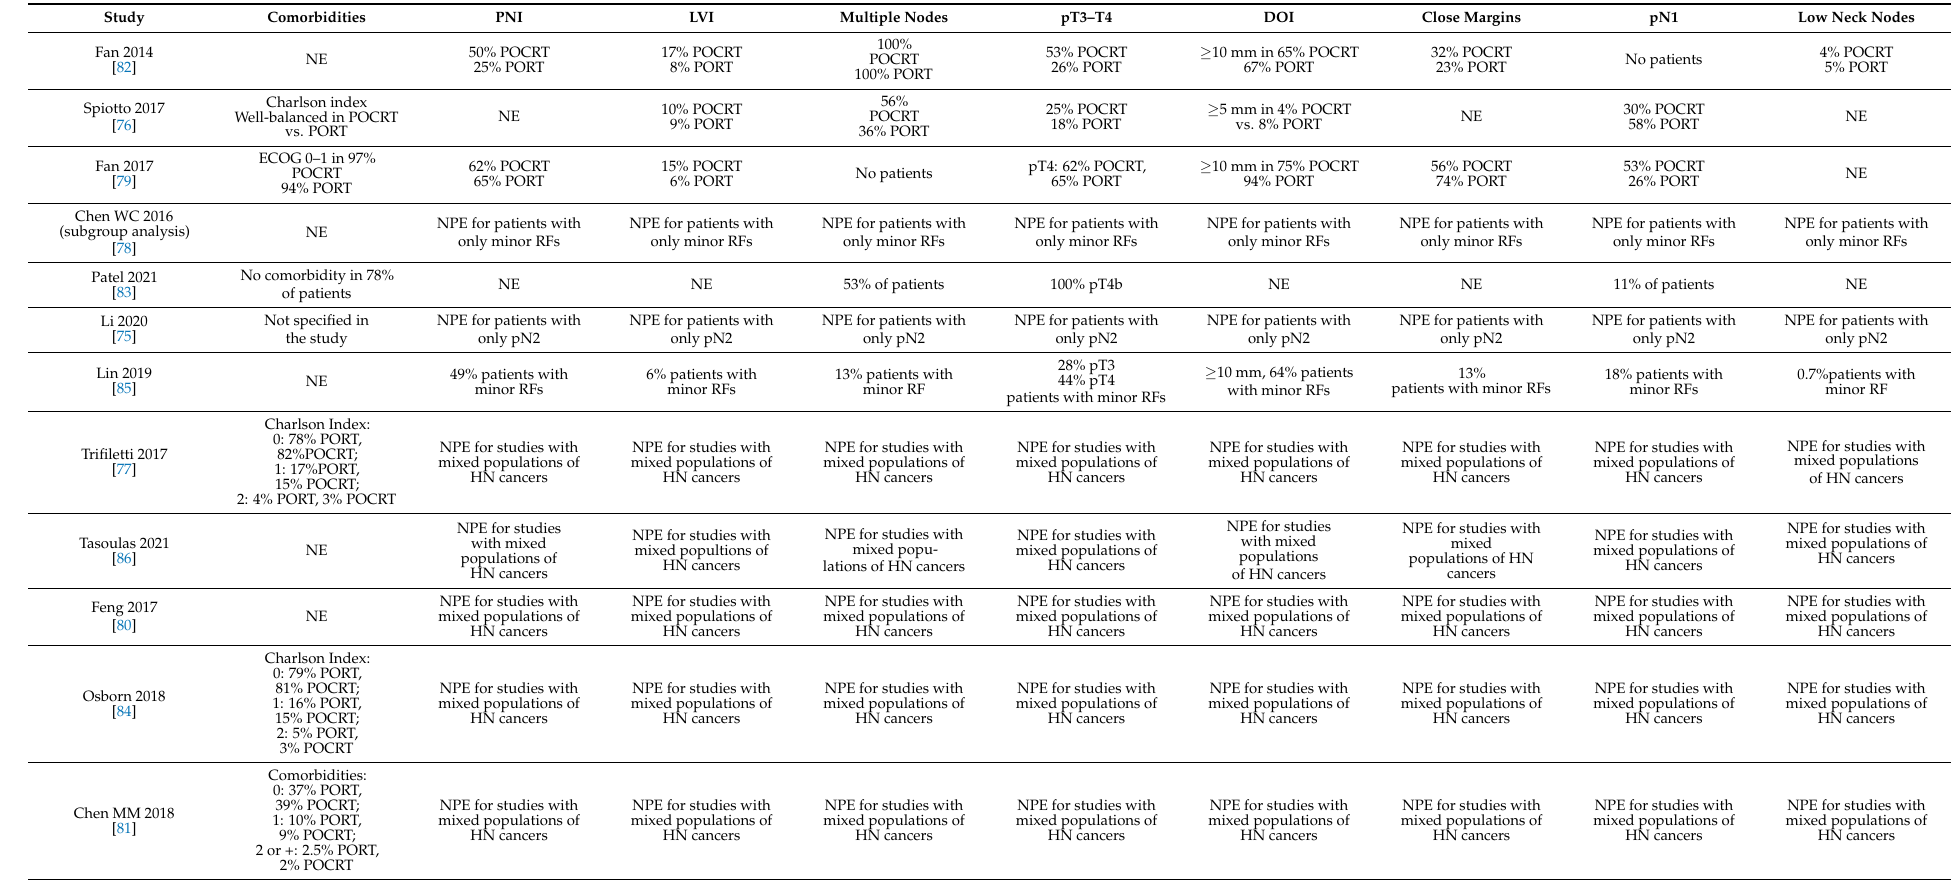
Table 3. Weights of comorbidities in all the included studies and percentages of each minor risk factor in studies with only OCC